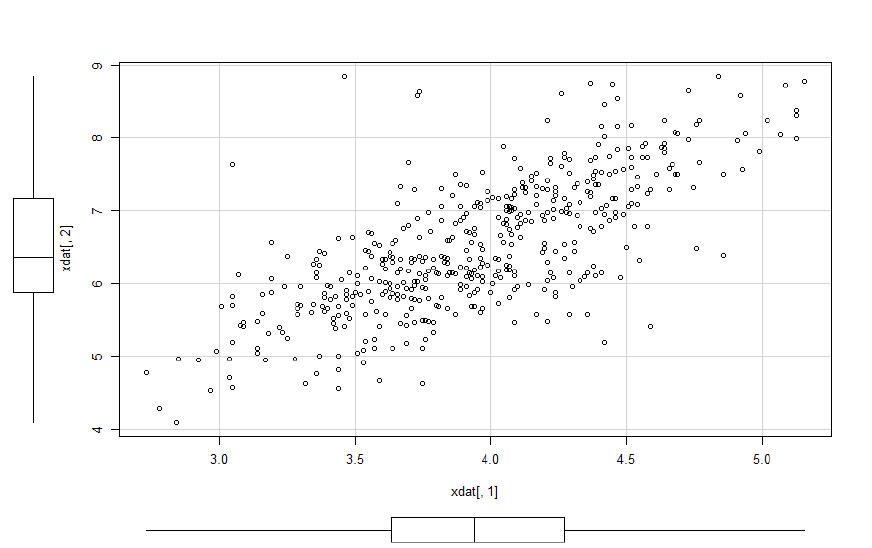
Figure 10. Scatter plot of the dataset 5 of